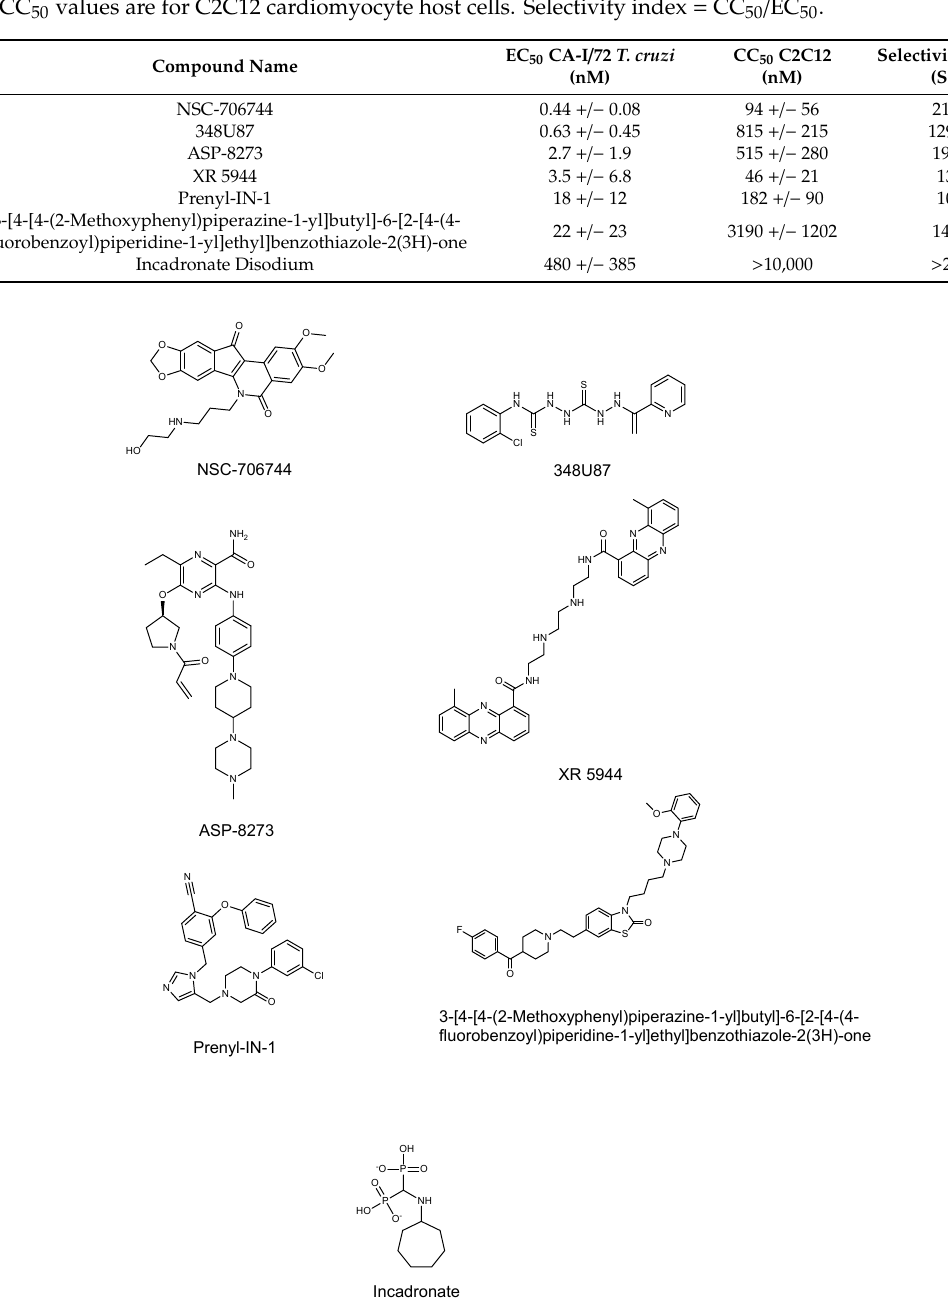
Figure 3. Chemical structures of hit compounds from the high-throughput screening campaign.